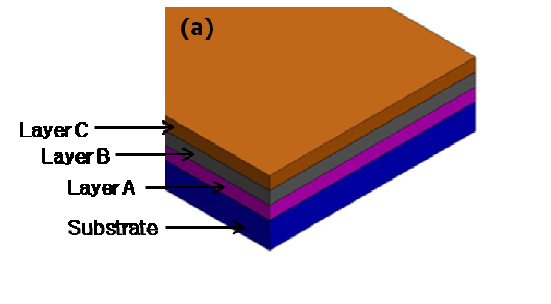
Figure 23. Tailored thin films potentially fabricated by MAND: ( a ) three different layers on a substrate; and ( b ) compositional